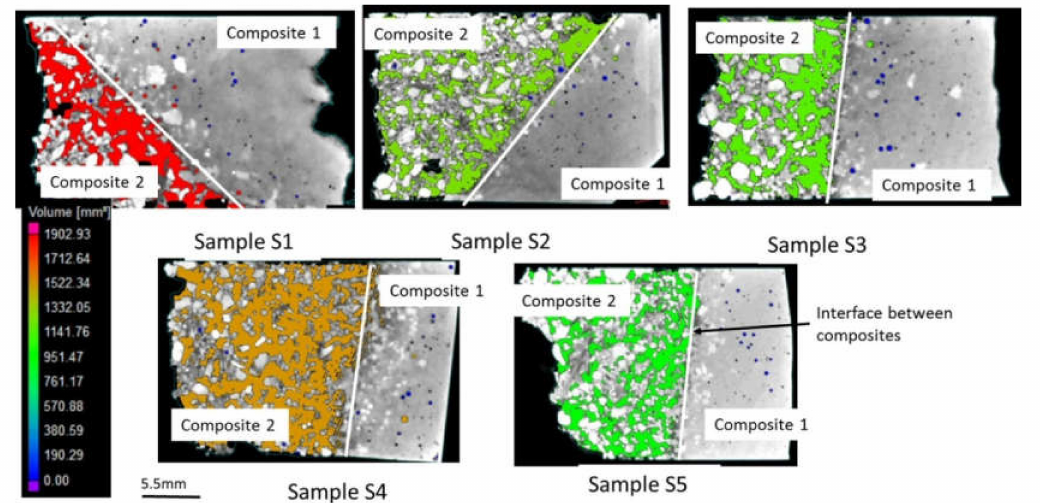
Figure 8. Representative CT cross-sections of composite 1 and composite 2, with color-coding of pore volumes for samples S1, S2, S3, S4, and S5. The color map and the scale are valid for all subfigures. The visible white lines indicate the interfaces between composites for all the samples.